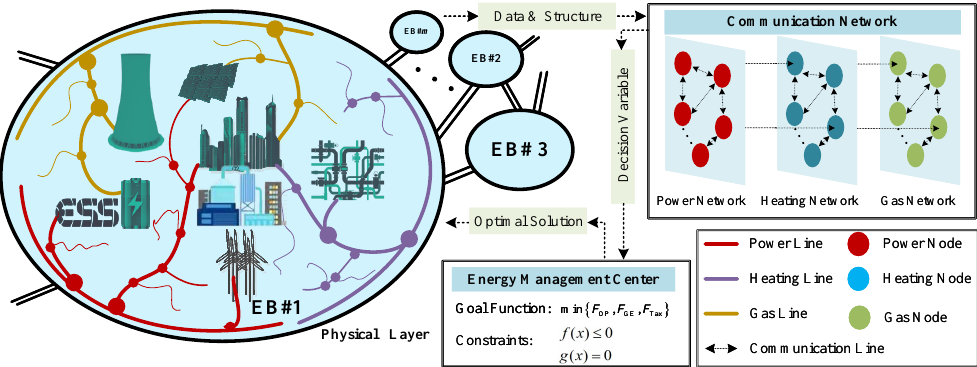
Figure 1. Basic structure of the seaport integrated energy